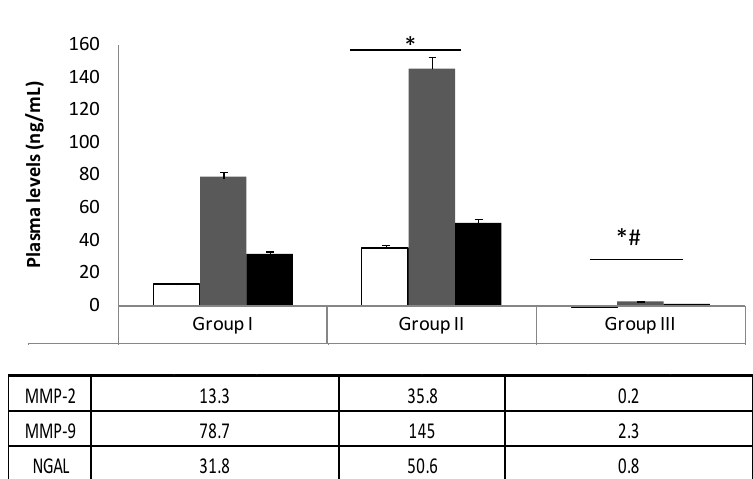
Figure 1. Plasma levels of matrix metalloproteinase (MMP)-2, MMP-9, and neutrophil gelatinase-associated lipocalin (NGAL) in enrolled patients at the time of admission (T = 0). Group I: aneurysmal patients using statins; Group II: aneurysmal patients, statin-free; Group III: control patients. Group III vs. Group I, * p < 0.01; Group III vs. Group II, # p < 0.01.